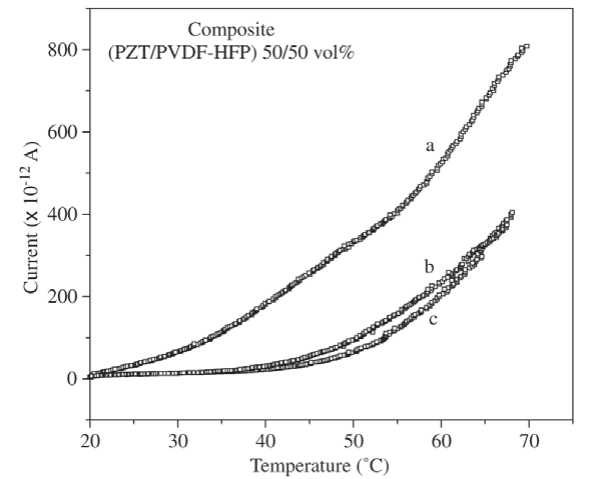
Figure 3. Typical thermally stimulated discharge current and pyroelectric current for the 90/10 PVDF-HFP copolymer: a) first run; b) second run; c) third run.